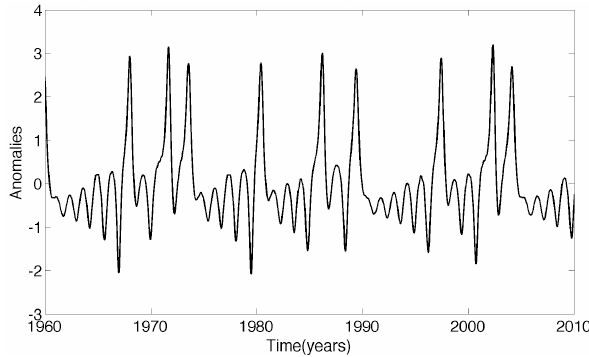
Fig. 1. Time series of slow model x o (t)